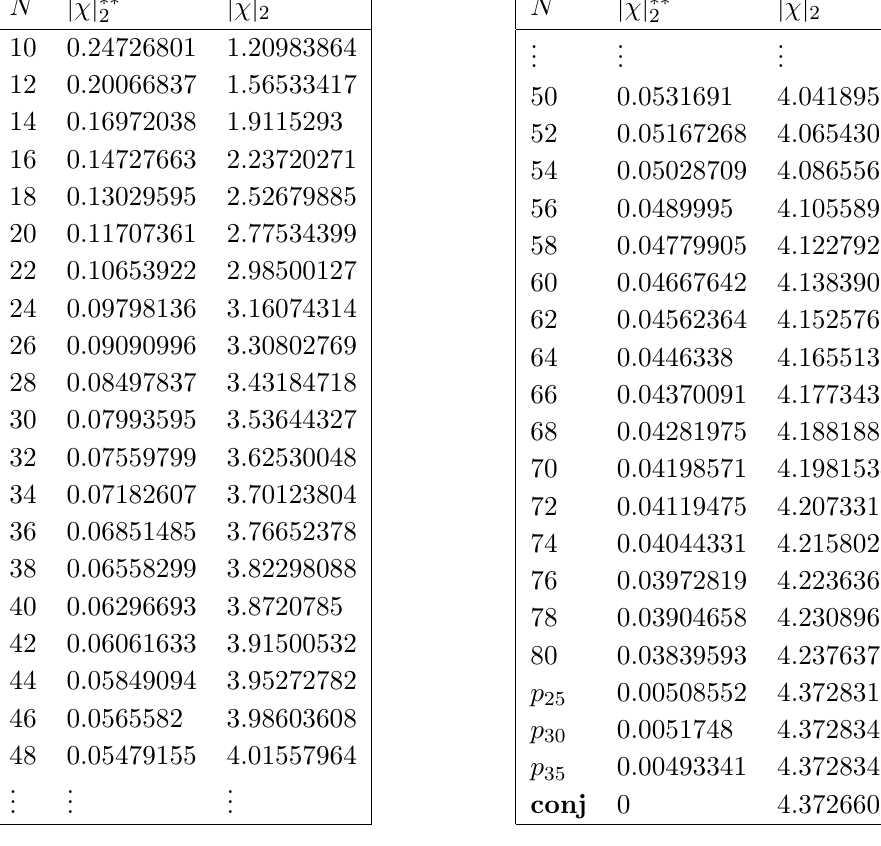
Values of j (cid:31) j 2 ; j (cid:31) j (cid:3)(cid:3) as de(cid:12)ned in (C.1), (C.2b), in the sector of S z = 2 at x = (cid:25) . 2 The state (cid:31) in (C.2) is here taken to be the result of acting upon the primary state obtained for S z = 2 ; e = (cid:0) 1 with the lowering operator A 1 ; 2 de(cid:12)ned from (1.3).The same conventions as table 3 are used for the extrapolation, and the CFT values (\conj") are computed using the general method described in section 5.2. Note that on the chiral side we do not project on the fourth relevant state, as discussed in section